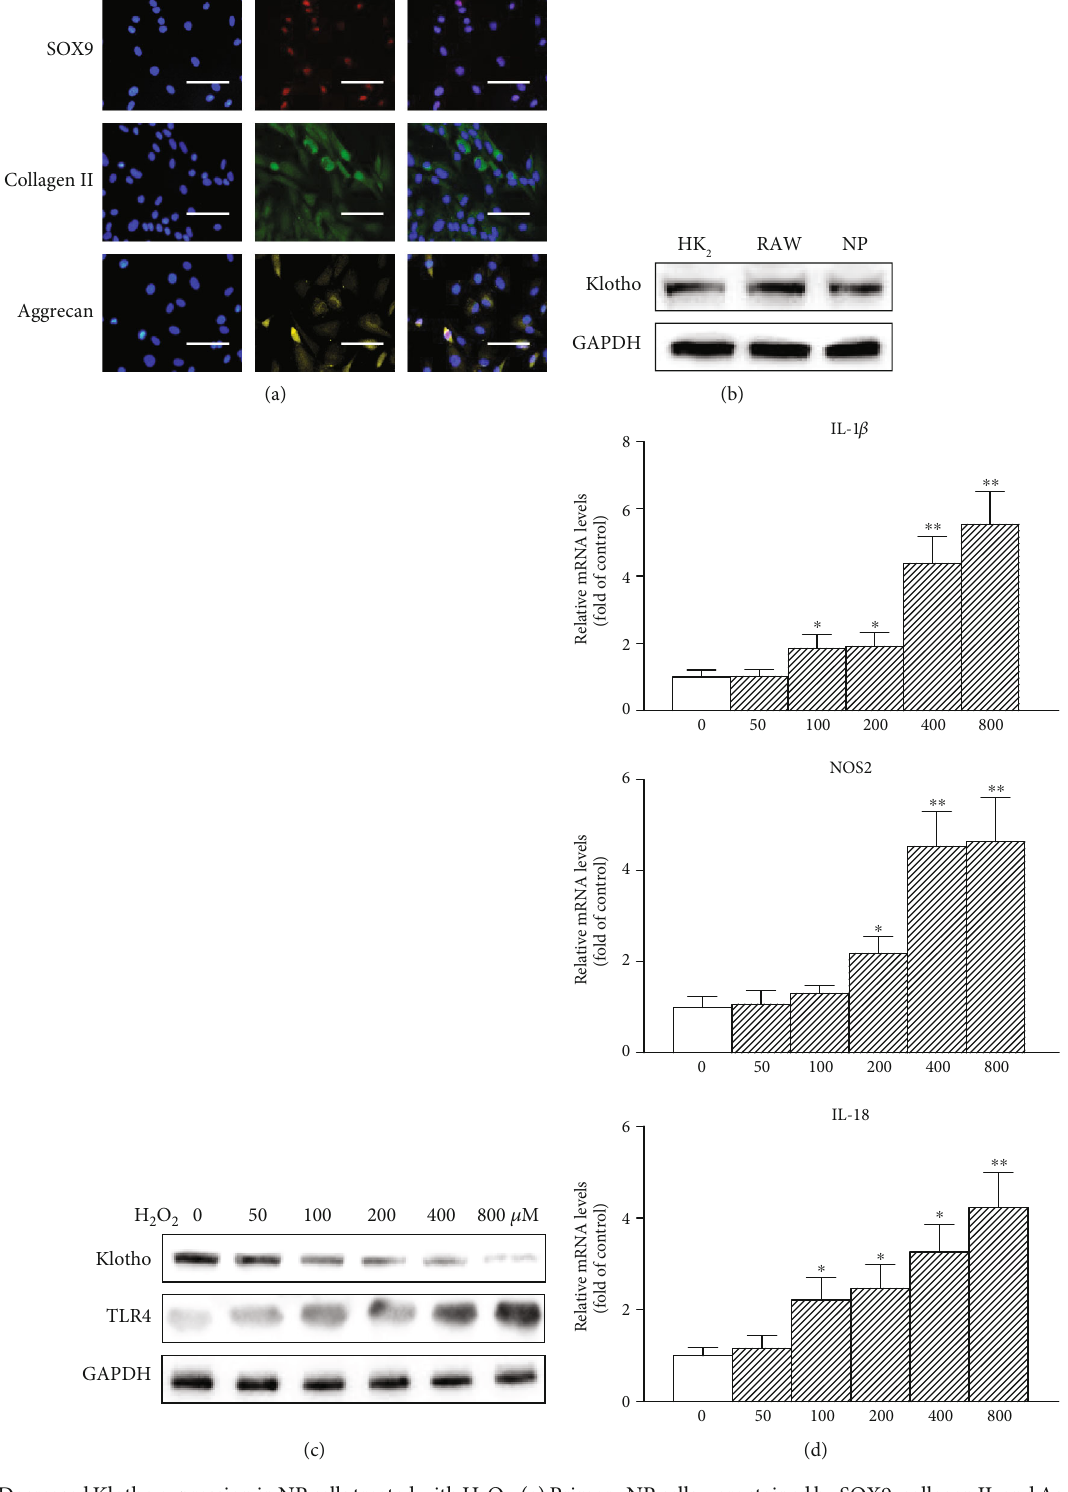
O .(a)PrimaryNPcellswerestainedbySOX9,collagenII,andAggrecan.To 2 2 O (0, 50, 100, 200, 400, and 800 μ M) for 12 h, and then 2 2 O (0, 50, 100, 2 2